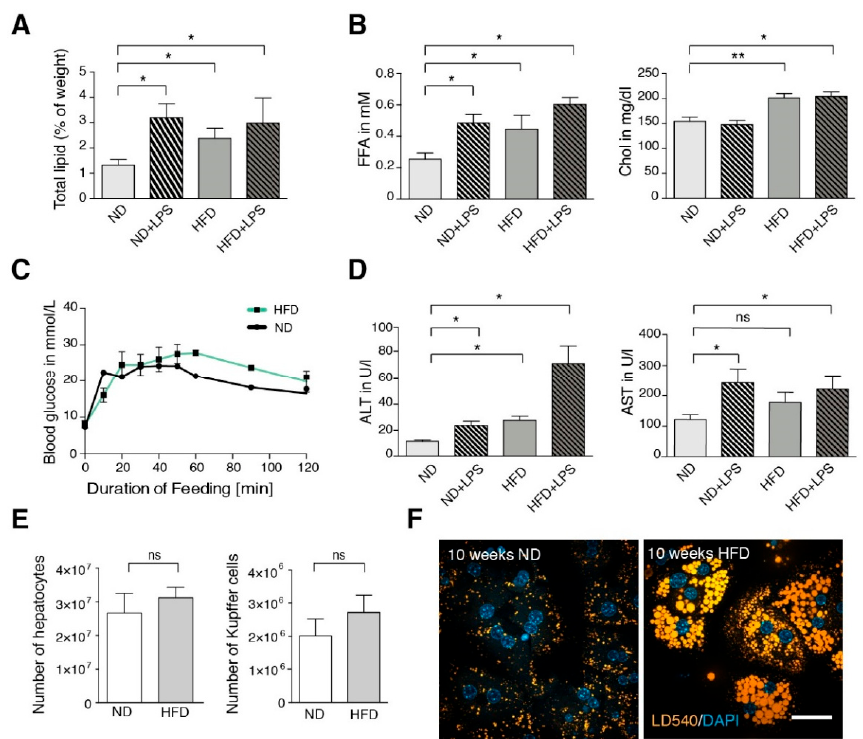
Figure 1. Characterization of liver and blood parameters in normal diet (ND) and high-fat diet (HFD) mice. ( A ) Averaged total lipid (weight %) in livers of ND and HFD mice ( n ≥ 3). ( B ) Serum levels of